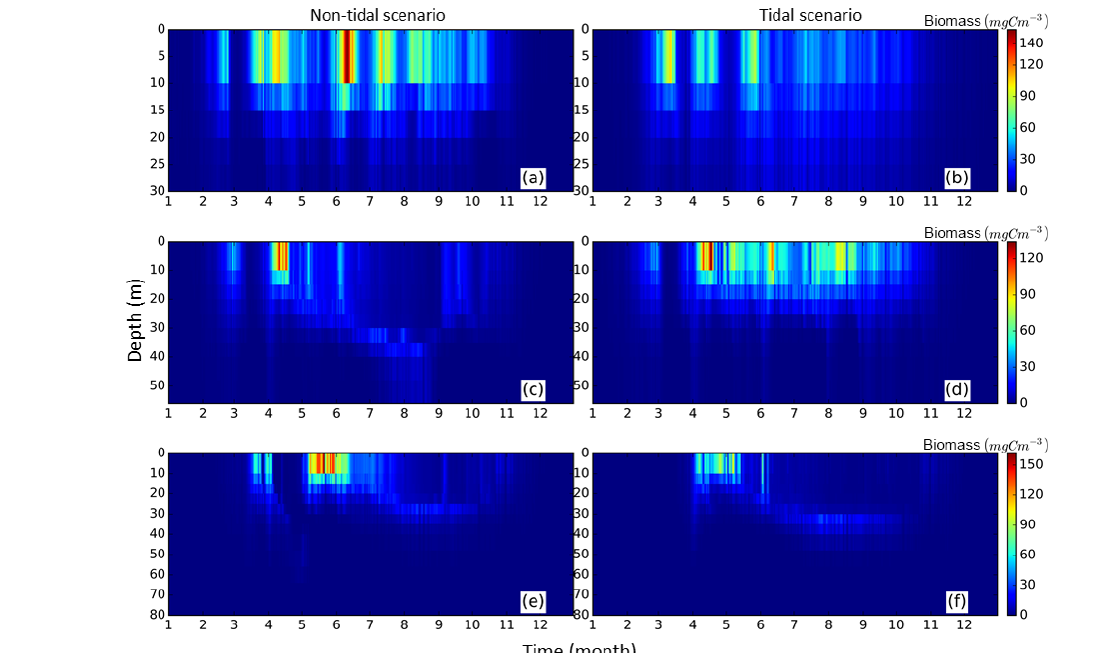
Figure A4. Annual mean (1990–2015) time series of vertical biomass profiles in the tidal (b, d, f) and non-tidal (a, c, e) scenarios at representative grid cells for the neg. SNS, the negatively responding southern North Sea (a, b) , pos. SNS, the positively responding southern North Sea (c, d) and for the deep NNS, the deeper northern North Sea (e, f) .